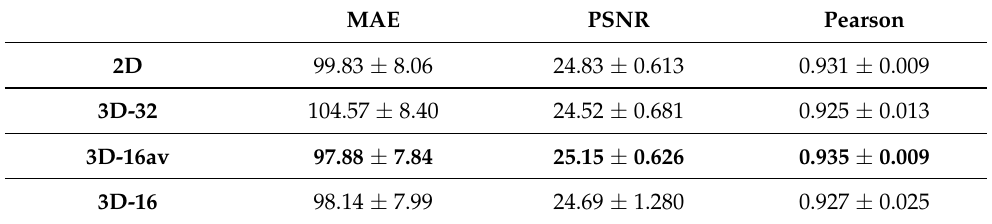
Table 3. Head dataset with Residual-Net. Mean Absolute Error, PSNR and Pearson coefficient on the head data set obtained using Residual net with different convolutions and